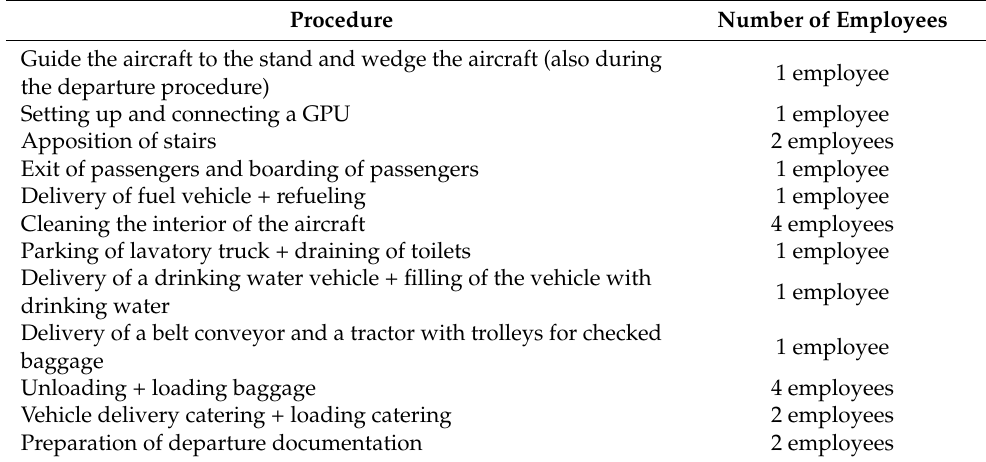
Table 2. Employees needed for aircraft ground handling.